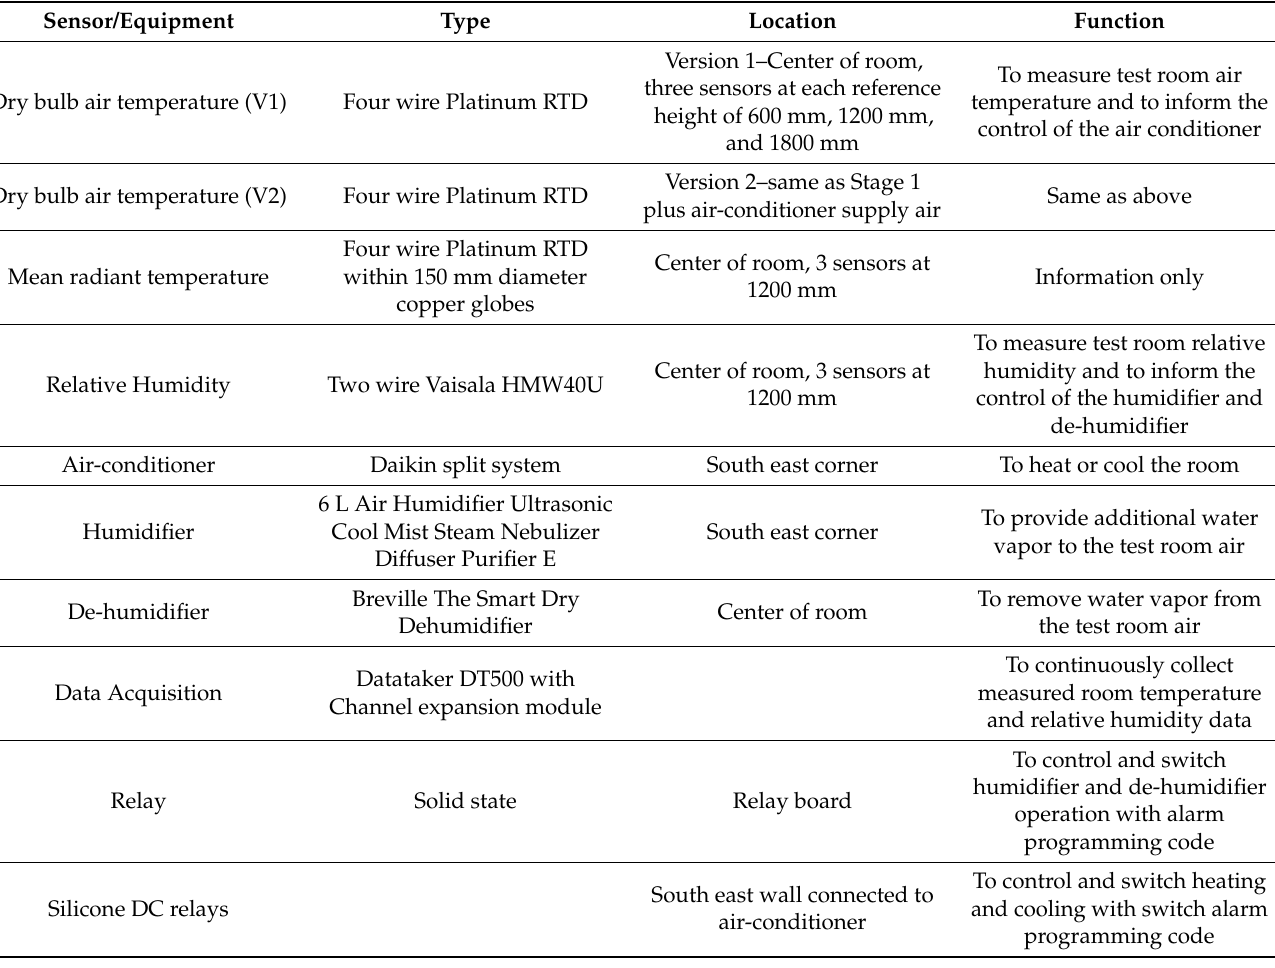
Figure 10. Wall-mounted heater.